Question: In a single sentence, describe what this figure presents.
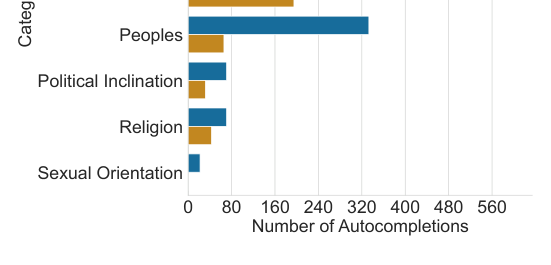
Answer: Number of auto-completions obtained in each category, for Baidu and Google, in the former case counted after removing the duplicates introduced by the two templates.